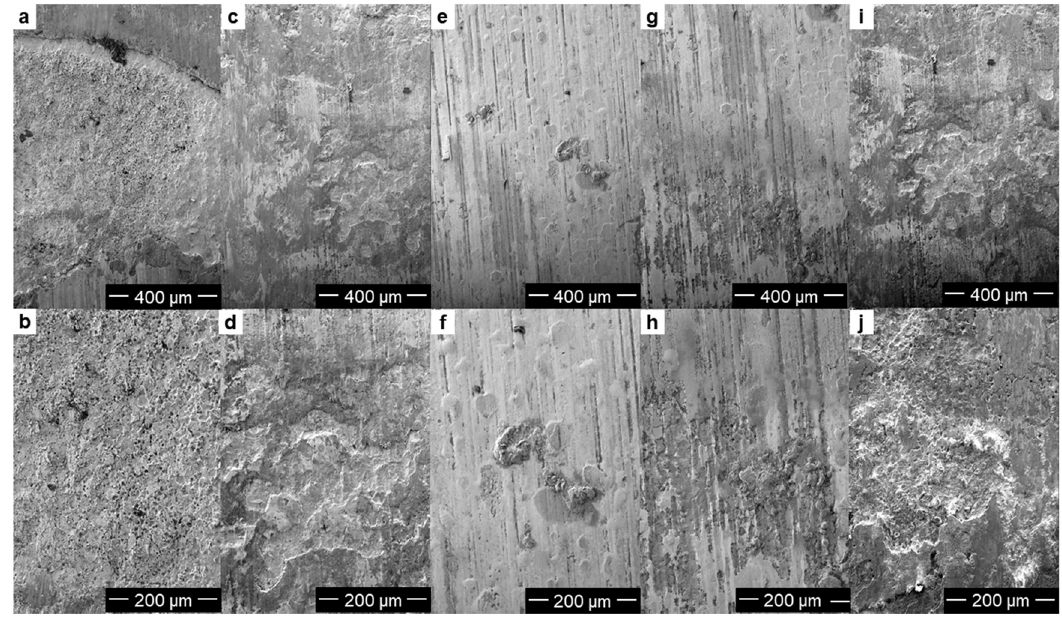
Figure 11: SEM images of the corrosion area of 0% ZIF - 67@EP ( a and b ) , 0.5% ZIF - 67@EP ( c and d ) , 1% ZIF - 67@EP ( e and f ) , 2% ZIF - 67@EP ( g and h ) , and 3% ZIF - 67@EP ( i and j ) coatings after 14 days of immersion in 3.5% NaCl ( aq )